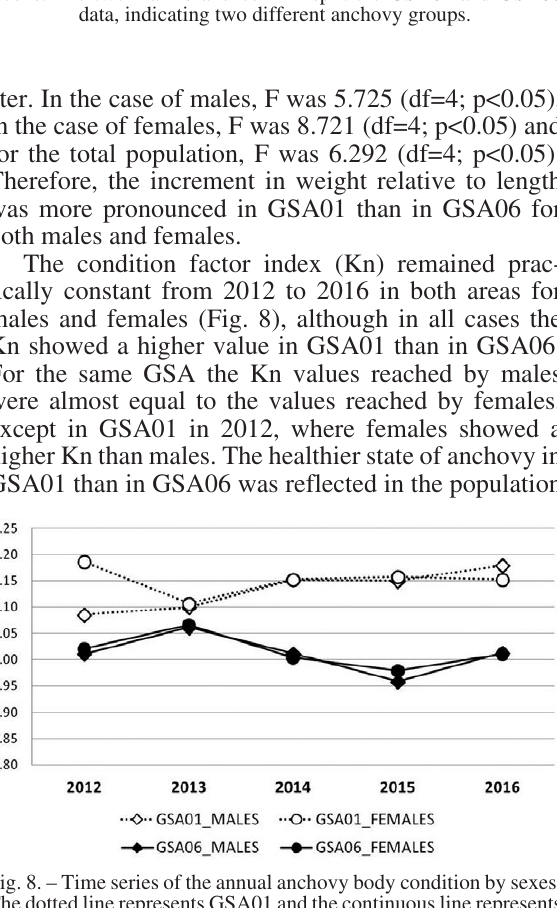
Fig. 7. – A, nMDS results and B, cluster analysis output depict- ing the linkage dendrogram (Bray-Curtis similarity) computed on length, weight and R1 for the five years and GSAs (stress: 0.02). The superimposed ellipses in A represent the two different groups detected, which correspond to the GSA06 and GSA01 anchovy stocks. The two main branches in B split the GSA01 and GSA06 data, indicating two different anchovy groups.